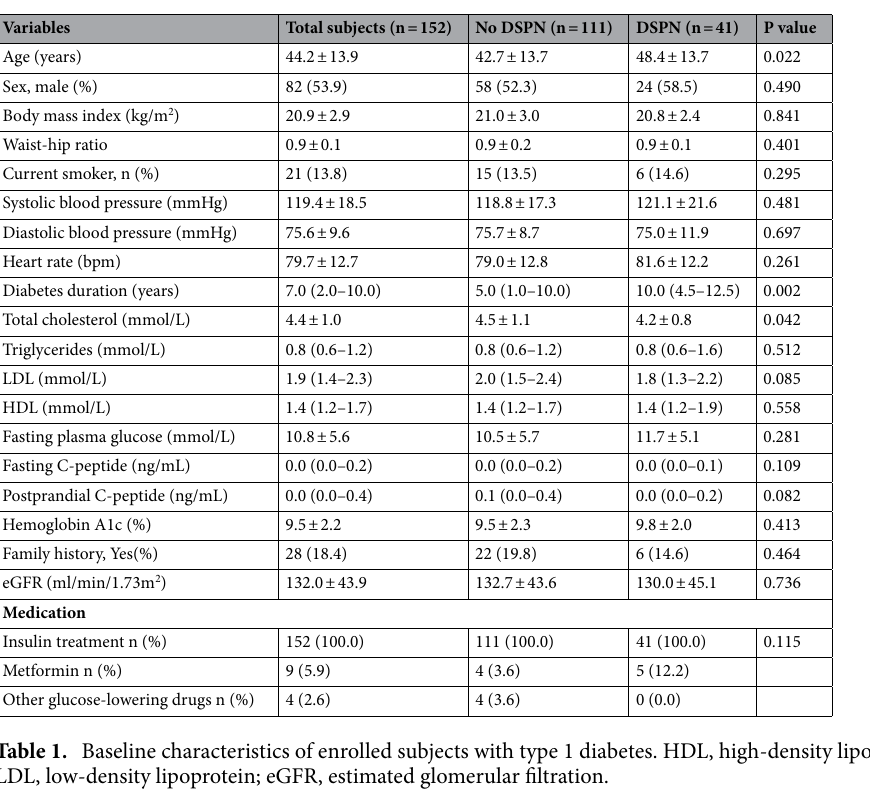
CGM parameters between groups. CGM profiles from day 2 were analyzed hourly to evaluate the glyce- mic variability. DSPN groups owned a higher blood glucose than those without DSPN between 00:00 and 12:59 (Fig. 1). Detailed CGM parameters were summarized in Table 2. Although there was no difference in mean glucose between individuals with and without DSPN, significant higher GV parameters such as CV and MAGE were observed in DSPN patients. Interestingly, we also observed significant upregulated percent time and AUC of hypoglycemia including level 1 and level 2 hypoglycemia, especially the nocturnal hypoglycemia in the DSPN